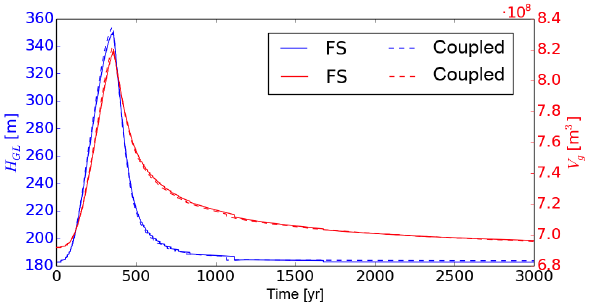
Figure 6. Time evolution of x GL (red) and u b (x GL ) (blue) with solid lines for FS and dashed lines for the coupled model. Figure 7. Time evolution of H GL = H(x GL ) and grounded volume V g with solid lines for FS and dashed lines for the coupled